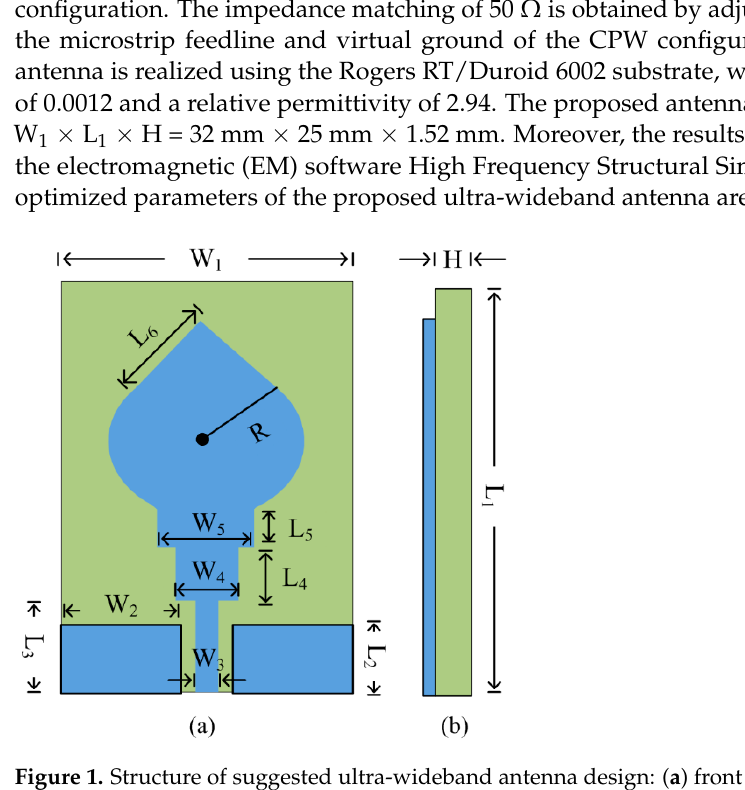
Figure 1. Structure of suggested ultra-wideband antenna design: ( a ) front view ( b ) side view. W 1 = 32, W 2 = 11, W 3 = 1.5, W 4 = 5, W 5 = 8, L 1 = 25, L 2 = 5, L 3 = 8, L 4 = 4, L 5 = 2, L 6 = 9.5, R = 8.5, H = 1.52; all units are in millimeters